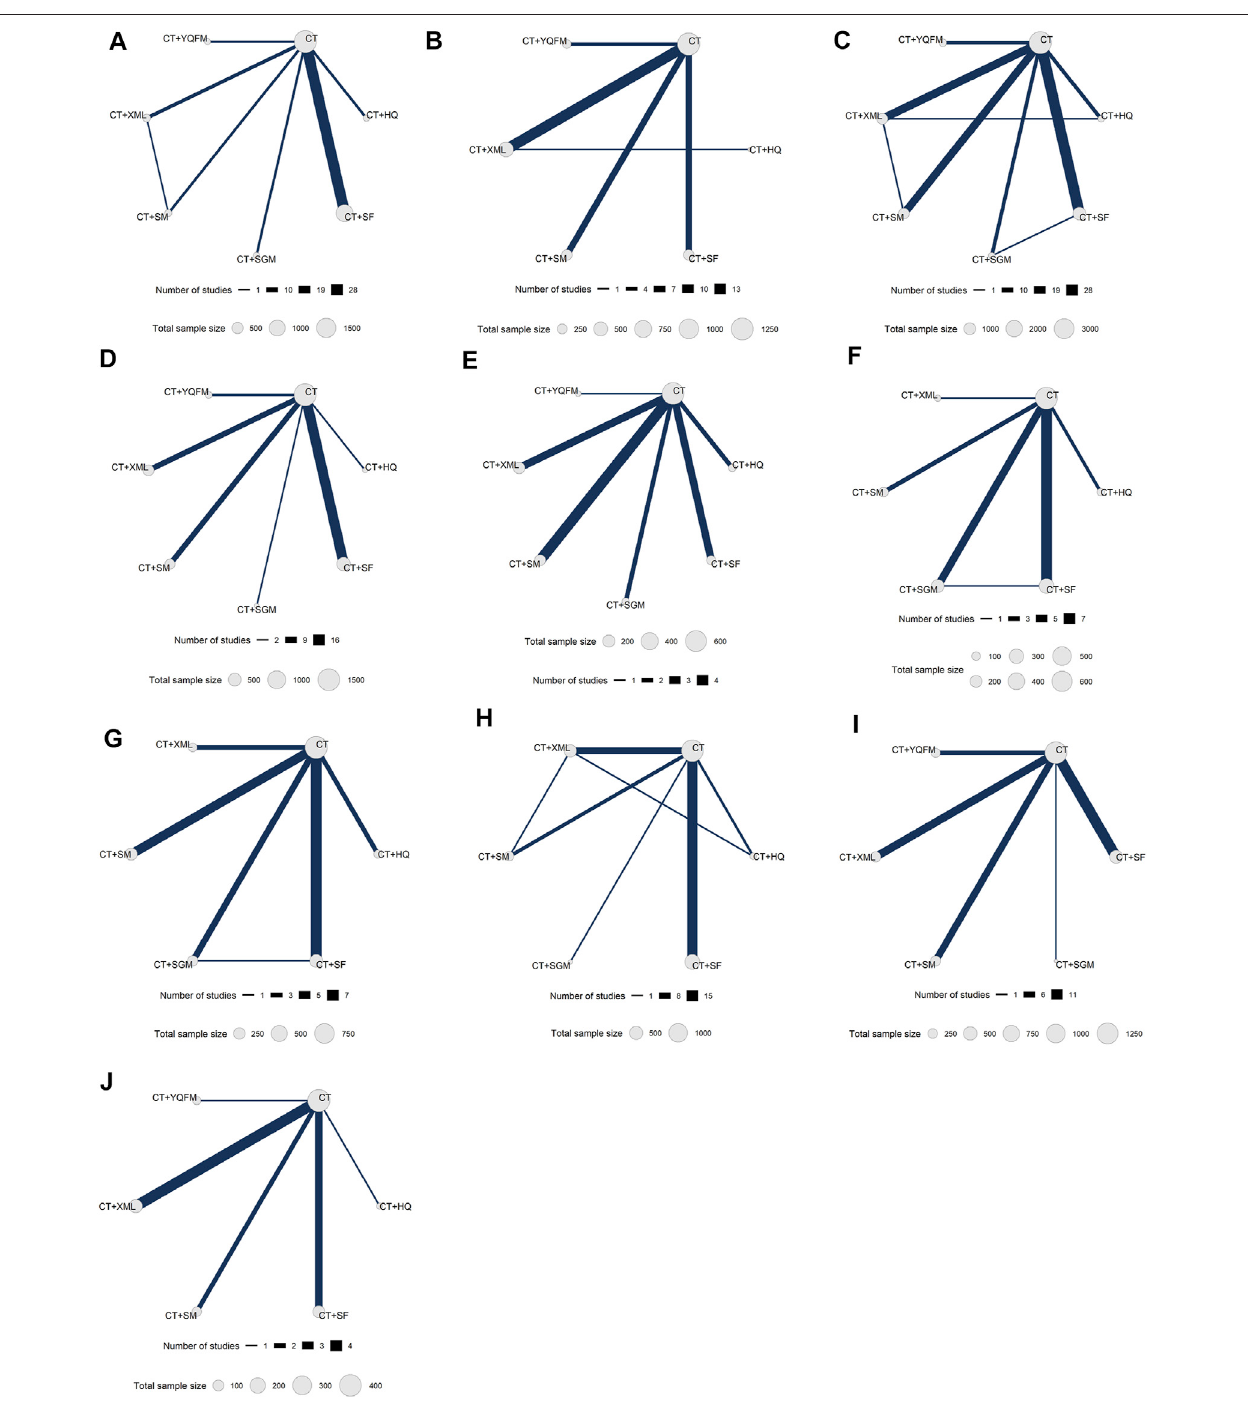
FIGURE 2 | Network diagrams for different outcomes. (A) New York Heart Association cardiac functional classi fi cation ef fi ciency; (B) 6-min walking test; (C) left ventricularejectionfraction; (D) leftventricular end-diastolicdiameter; (E) leftventricular end-systolic diameter; (F) cardiac output; (G) strokevolume; (H) brainnatriuretic peptide; (I) N-terminalpro-brainnatriureticpeptide; (J) MinnesotaLivingwithHeartFailureQuestionnaire.CT,conventionaltreatment;HQ,Huangqiinjection;SF,Shenfu injection; SGM, Shengmai injection; SM, Shenmai injection; XML, Xinmailong injection; YQFM, Yiqifumai lyophilized injection.